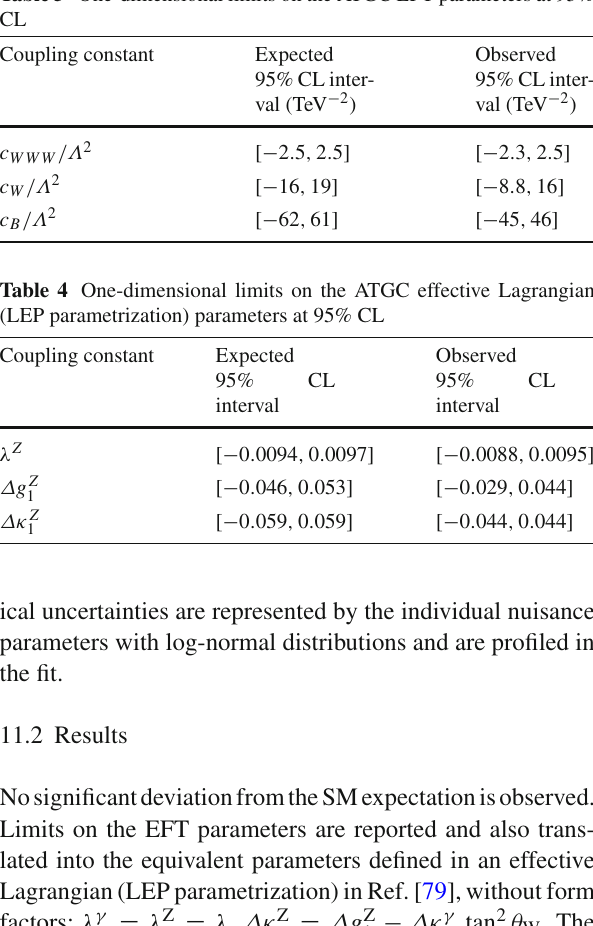
Table 3 One-dimensional limits on the ATGC EFT parameters at 95% CL Coupling constant Expected 95% CL inter-